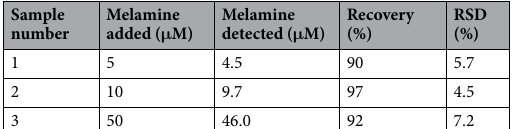
Table 2. Recovery data for feed samples added with different concentrations of melamine (n =